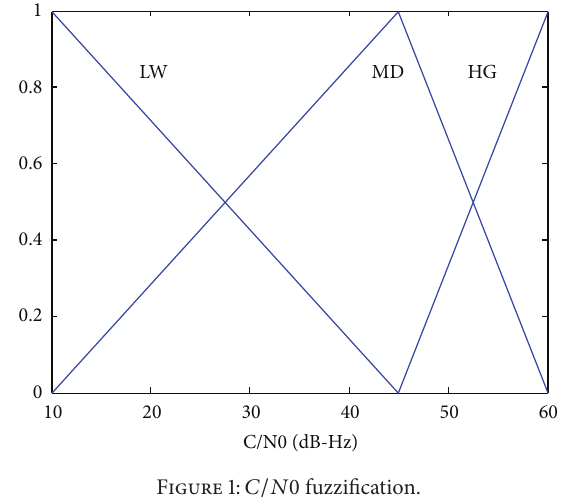
Figure 1: 𝐶/𝑁 0 fuzzification.